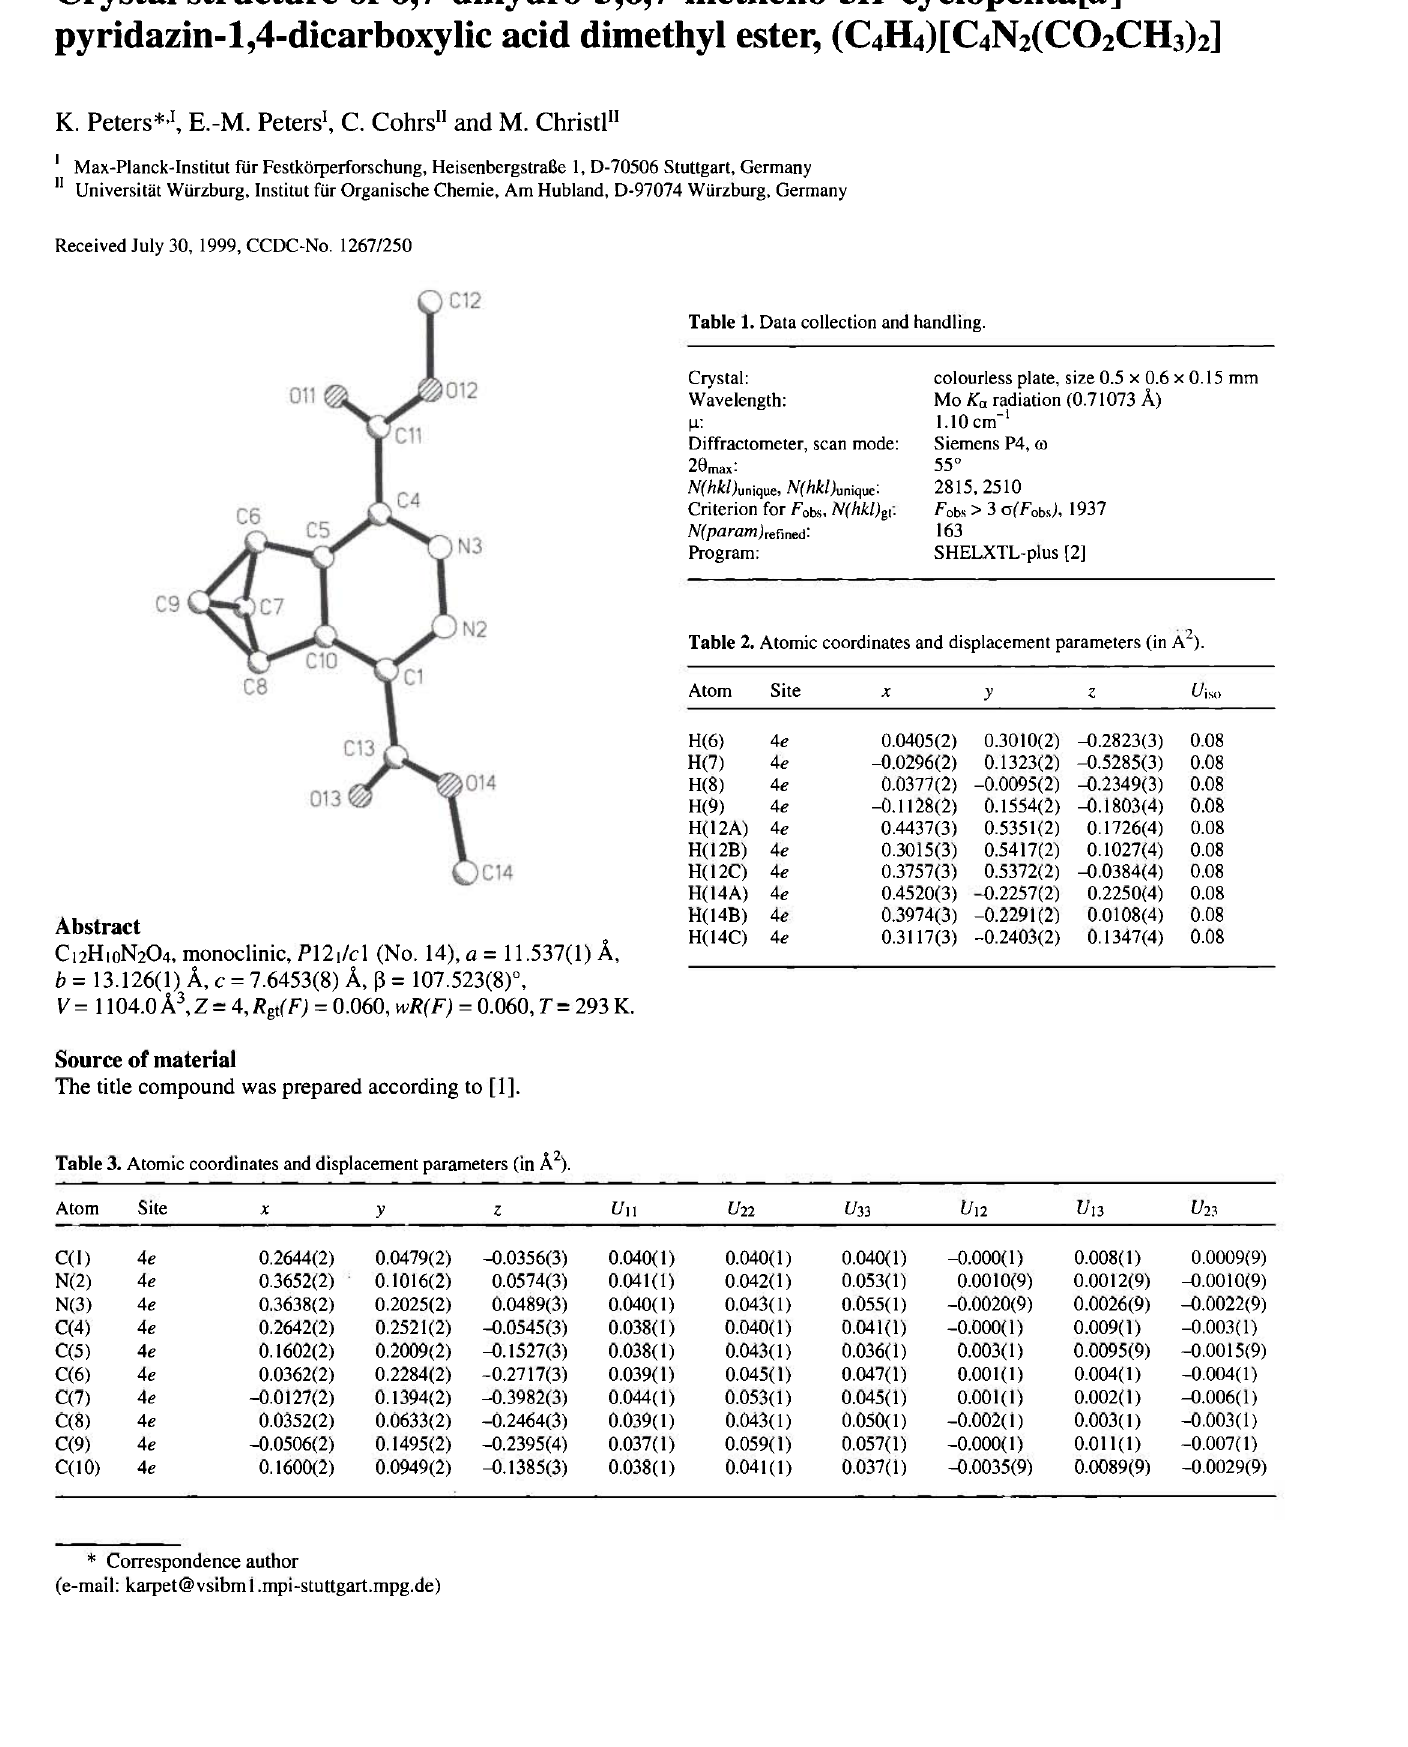
Table 3. Atomic coordinates and displacement parameters (in Ä 2